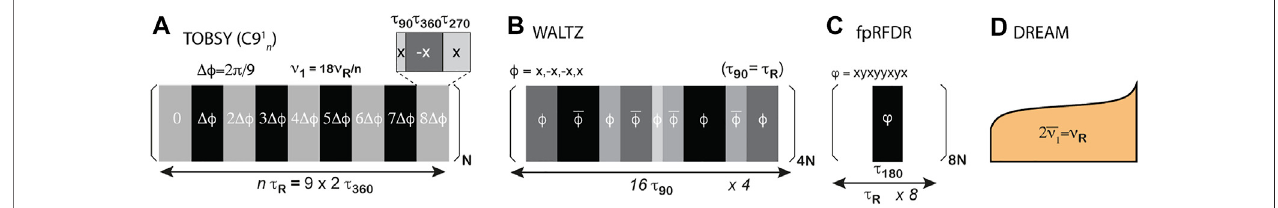
FIGURE 3 | RF schemes of 13 C mixings compared in this study. (A) TOBSY C9 1 n variants with variable n . (B) WALTZ-16, a representative of TOCSY class. The primitive element is composed of phase-alternated 90, 180, 270, and 360 ° pulses, depicted as rectangles color-coded from light gray to black . (C,D) Transfer